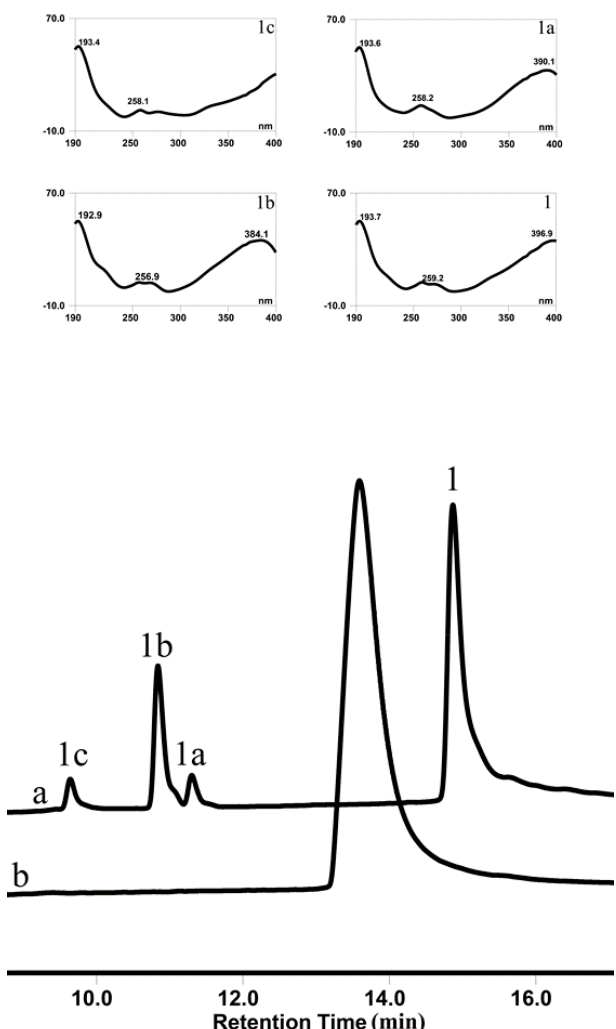
Figure 4. HPLC chromatogram of reaction product of sulfuretin ( 1 ) incubated with OsUGT1 ( a ) or without OsUGT1 ( b ). UV spectra of 1 and three enzymatic products 1a , 1b and 1c are shown in upper panels.